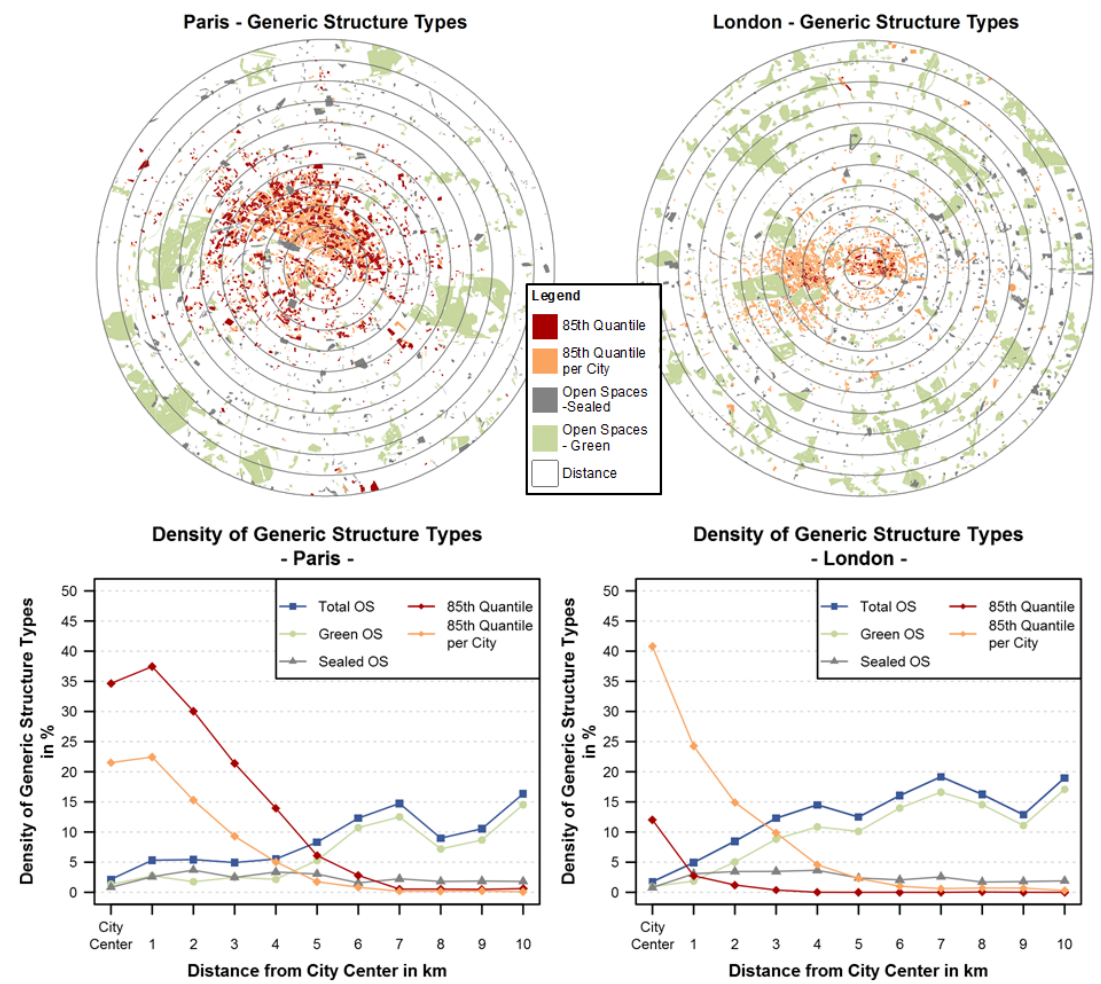
Figure 11. Mapping appearance of generic structural classes (open spaces and highest built-up density) at block units; gradient analysis of the two generic structural classes (specified for open spaces in sealed and green open spaces).